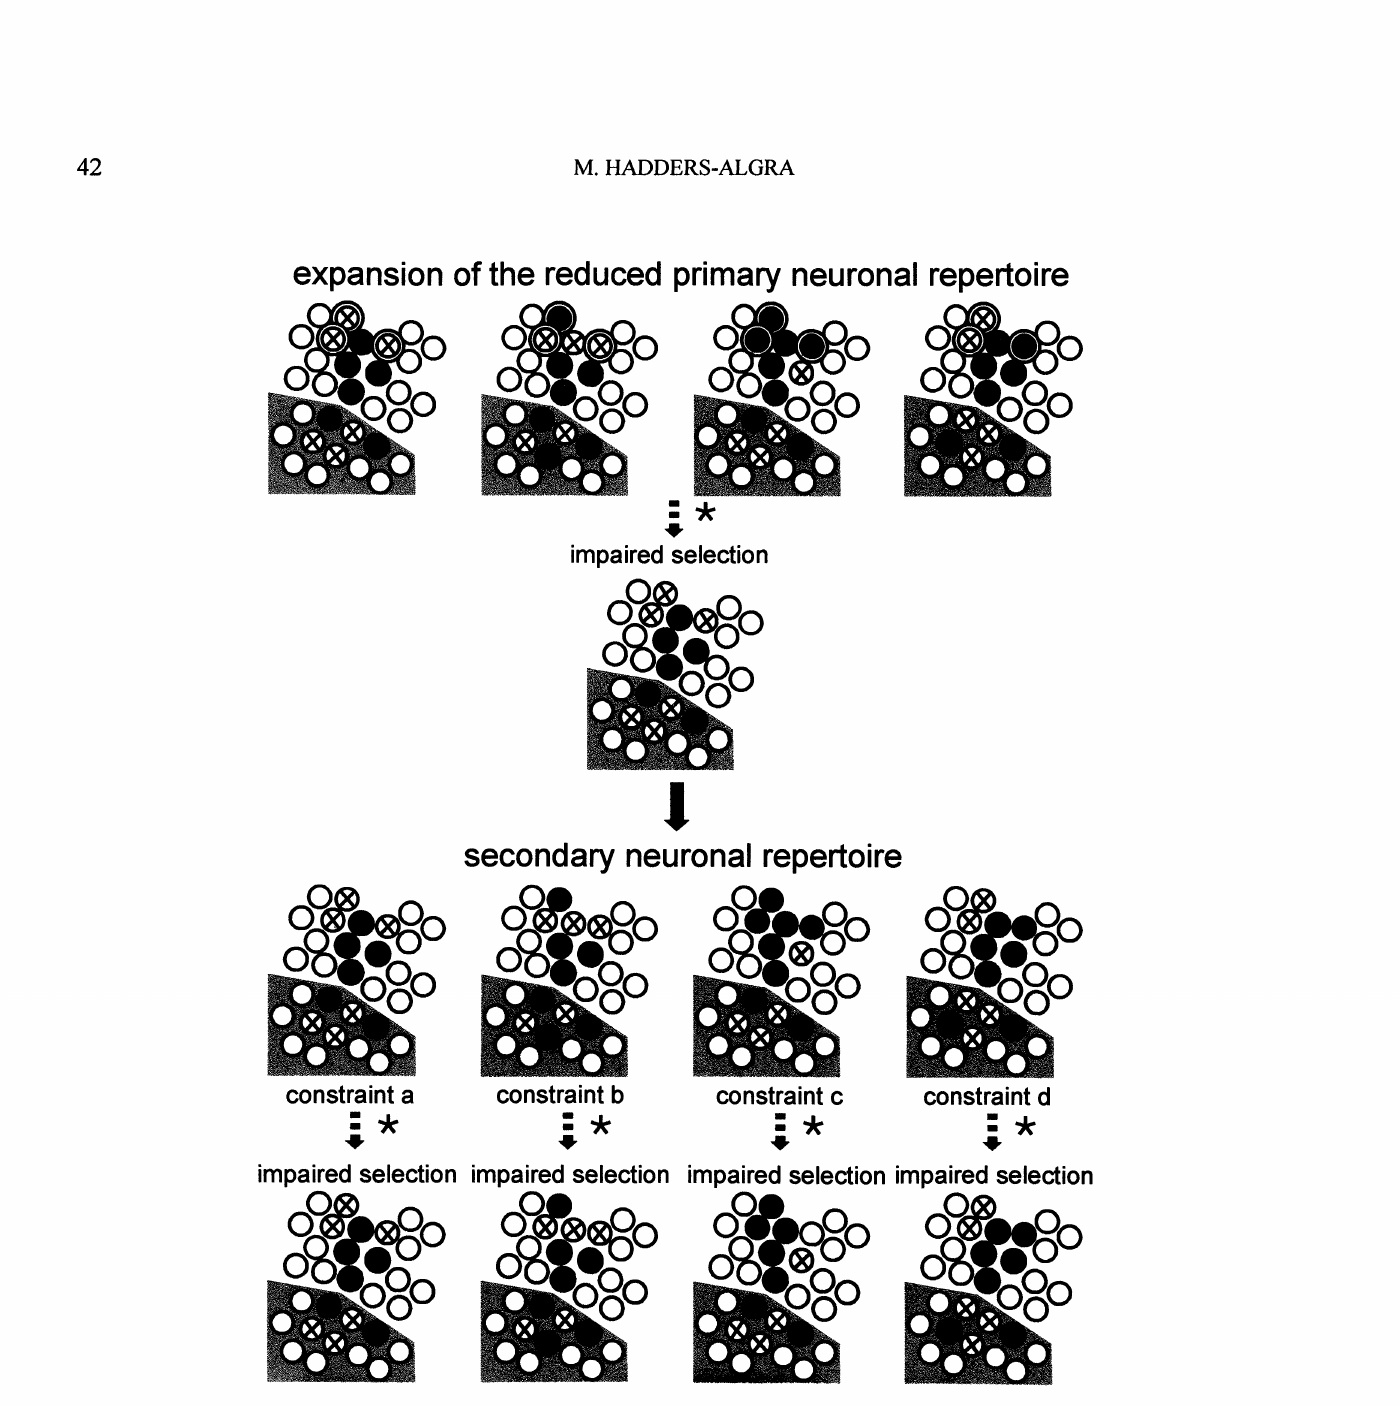
Fig. 4: Schematic diagram of the putative mechanisms of intervention after brain lesion at early age, based on the principles of NGST. The diagram is a twin partner of Fig. (see legends of Fig. 1). The lower grey area denotes a lesion of the brain at early age. The lesion of the brain resulted in a reduction of the primary repertoire of the filled clusters; only four of the originally nine participating clusters were le (cf, Fig. 1). NGST suggests that at early age intervention should focus on augmentation of the primary repertoires. This is illustrated at the upper row of the diagram. Plastic changes induced a functional change of three neighboring clusters. This is indicated by the three clusters, which were non-filled in Fig. 1, but are depicted here with filled circles with double margins. Thus, the reorganization resulted in a restoration of a part of the lost variation. NGST suggests that at older ages, the focus of intervention should be on the provision of ample opportunities for active practice, as a richness in practice might form a compensation for the impaired selection processes (point offocus indicated by (-k) in the